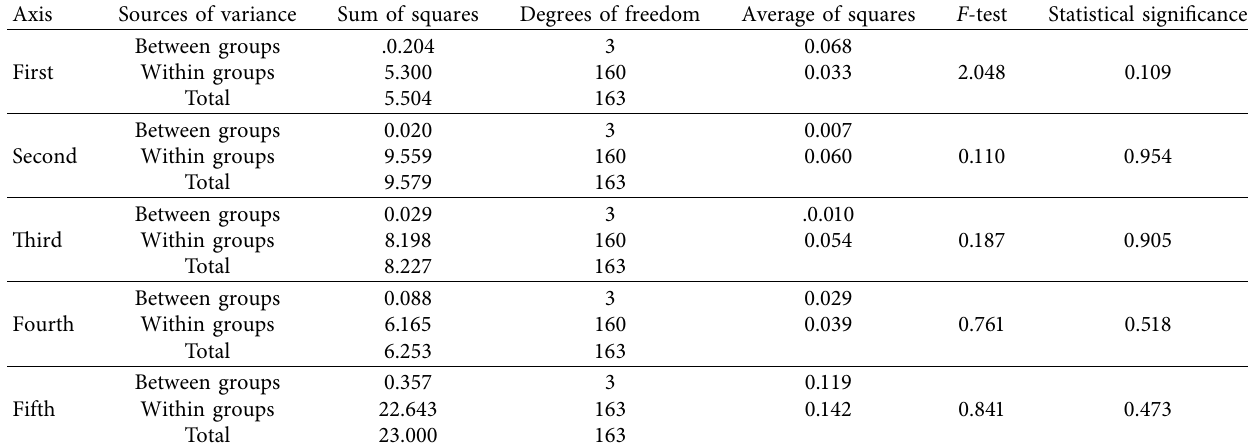
The fifth axis: the proposed training methods to develop the skills of the UOH staff on the use of MTM Table 10: Results of the F -test for a comparison between the averages of responses to the questionnaire on the reality of the use of MTM by staff at the UOH according to academic